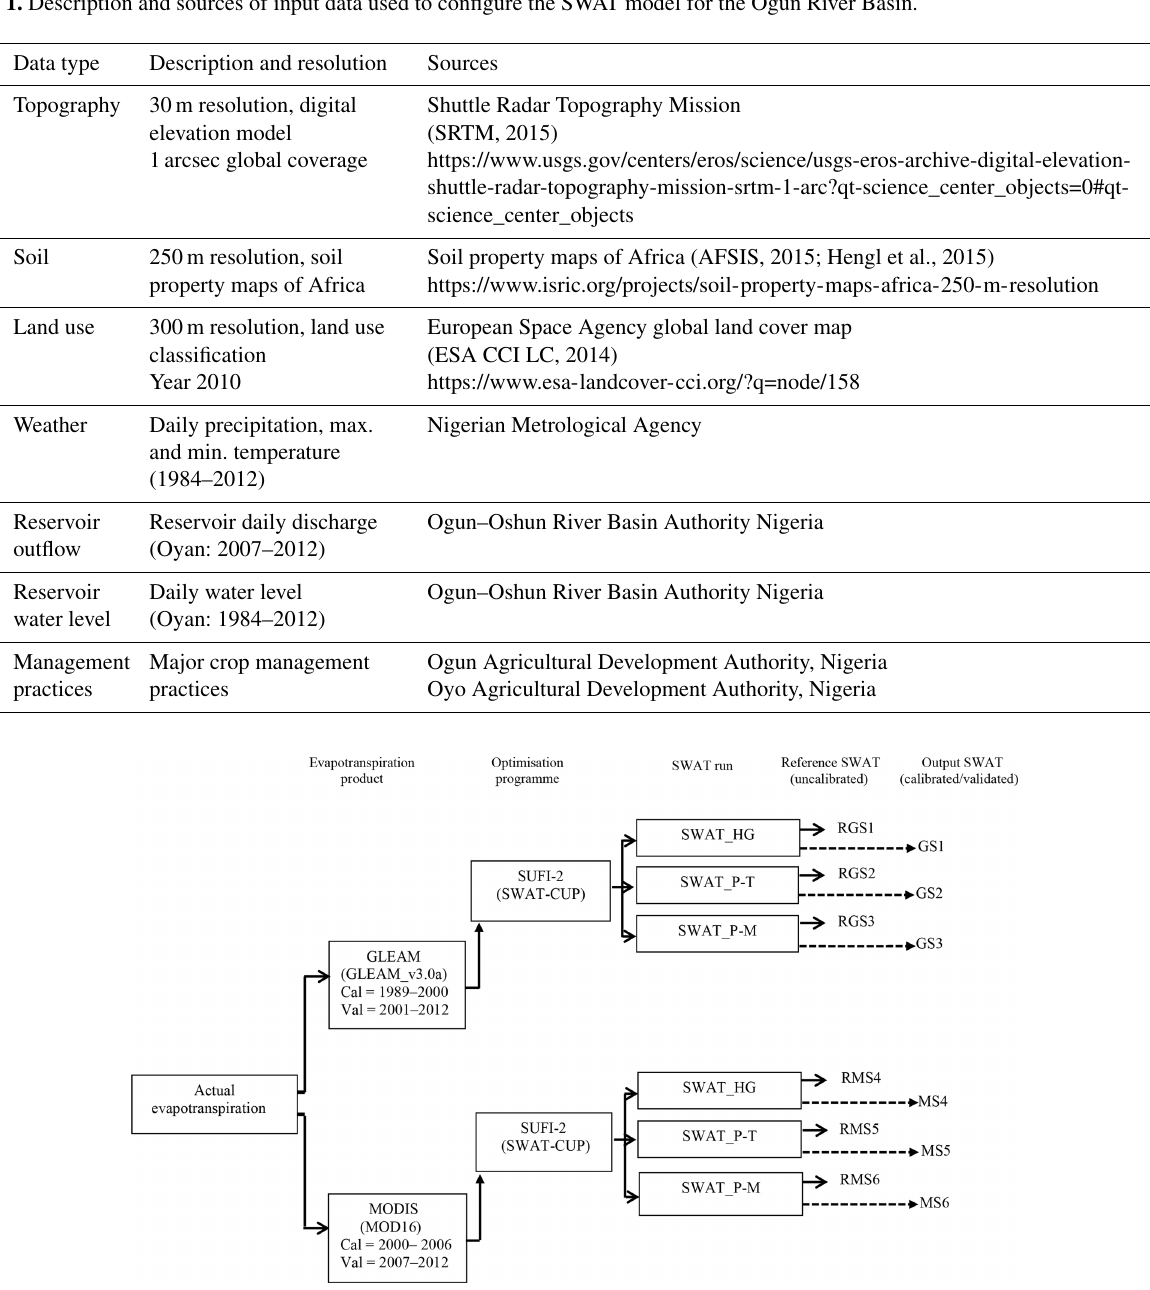
Figure 2. Schematic diagram showing the set-up of the SWAT model, the two global AET products, the resulting six SWAT reference runs, and calibration and validation procedures for the Ogun River